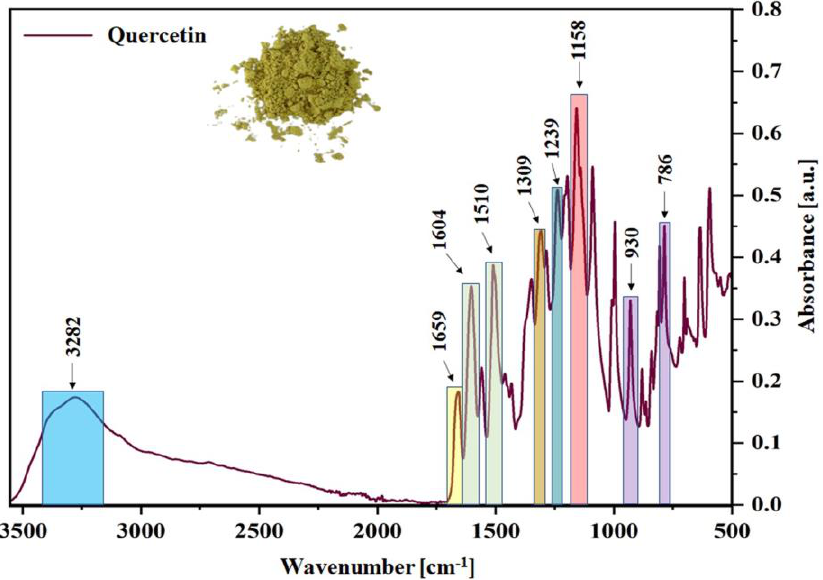
Figure 1. FT−IR absorption spectrum of pure quercetin powder with its characteristic peaks marked.